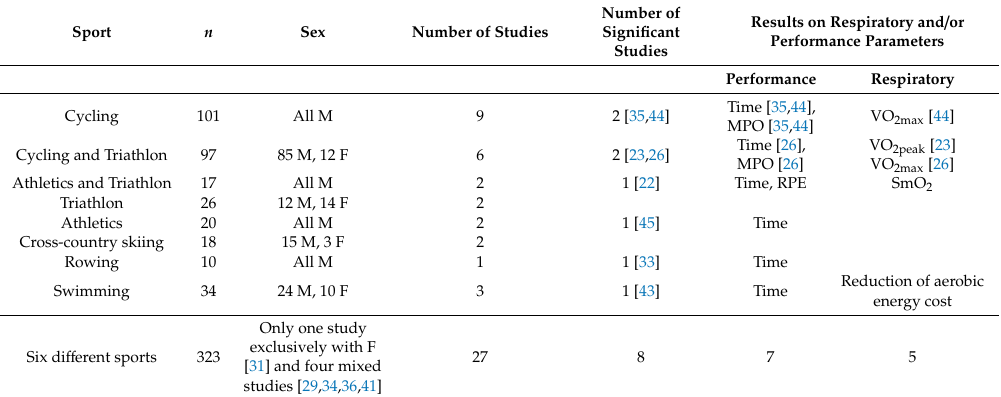
Table 4. Summary table with studies on the cyclic endurance performance of trained athletes. Sport